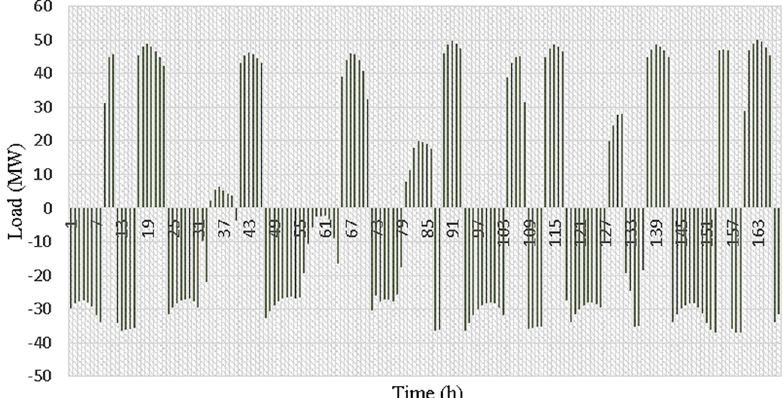
Figure 9. Difference between the demand level and the actual electricity consumption over the scheduling time horizon.